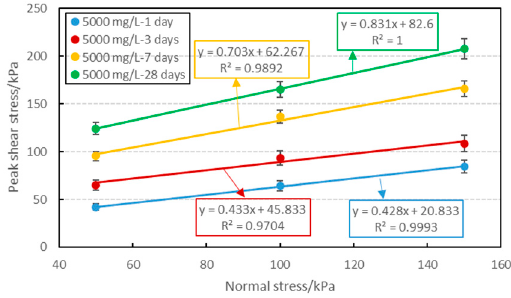
Figure 15. Shear envelops of the FR ‐ CPB/rock interface (CPB made with 0.3% fibers; sulfate concentration of 5000 mg/L).